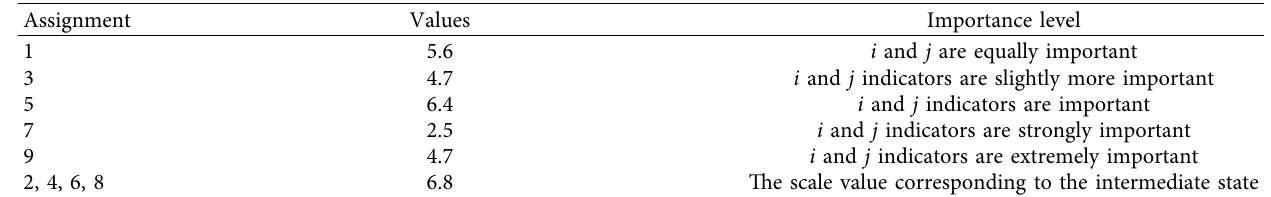
Figure 2: Schematic diagram of the traffic system model. Table 1: Level 9 scale and meaning.